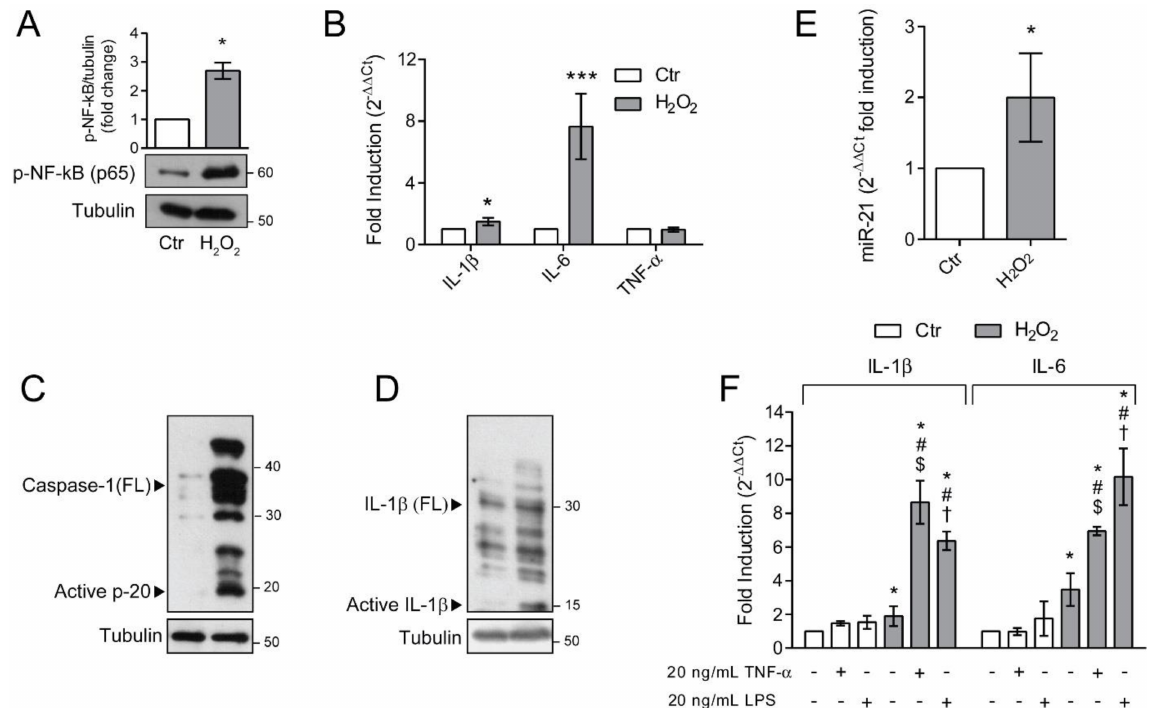
Figure 5. Senescent ARPE-19 cells show an inflammatory phenotype. Ctr and H 2 O 2 treated cells were seeded in H 2 O 2 -free medium and grown for 72 h and used for experiments ( A ) Western Blotting of phosphorylated NF- κ B p65. α -tubulin was used as loading control. Bar graphs represent the densitometric analysis reported as the ratio between protein and α -tubulin band intensity. Untreated cells were used as control and assumed as 1. One representative blot is shown and densitometric analyses are expressed as the mean ± SD of three independent experiments; ( B ) gene expression of IL-1 β , IL-6 and TNF- α assessed by qPCR. Gene expression values were normalized to GAPDH and presented as 2 − ∆∆ Ct . Relative mRNA gene abundance in untreated cells was assumed as 1 (control). Data represent the mean ± SD from n = 5 independent experiments performed in triplicate. (* p < 0.05, *** p < 0.001); ( C , D ) Western Blot analysis of Caspase-1 and IL-1 β full length (FL) and cleaved active fragments. α -tubulin was used as loading control. Bar graphs represent the densitometric analysis reported as the ratio between protein and α -tubulin band intensity. Untreated cells were used as control and assumed as 1. One representative blot is shown and densitometric analyses are expressed as the mean ± SD of three independent experiments; ( E ) Expression of miR-21 by qPCR. Gene expression values were normalized to U6snRNA and presented as 2 − ∆∆ Ct . Relative mRNA gene abundance in untreated cells was assumed as 1 (control). Data represent the mean ± SD of three independent experiments; ( F ) Ctr and H 2 O 2 -treated cells were exposed to 10 µ g/mL LPS or 20 nM TNF α for 6 h before harvesting. Gene expression of IL-1 β and IL-6 was assessed by qPCR. Gene expression values were normalized to GAPDH and presented as 2 − ∆∆ Ct . Relative mRNA gene abundance in untreated cells was set to 1 (control). Data represent the mean ± SD from n = 3 independent experiments performed in triplicate. (* at least p < 0.05 vs. Ctr non-treated (–); # p < 0.05 vs. H 2 O 2